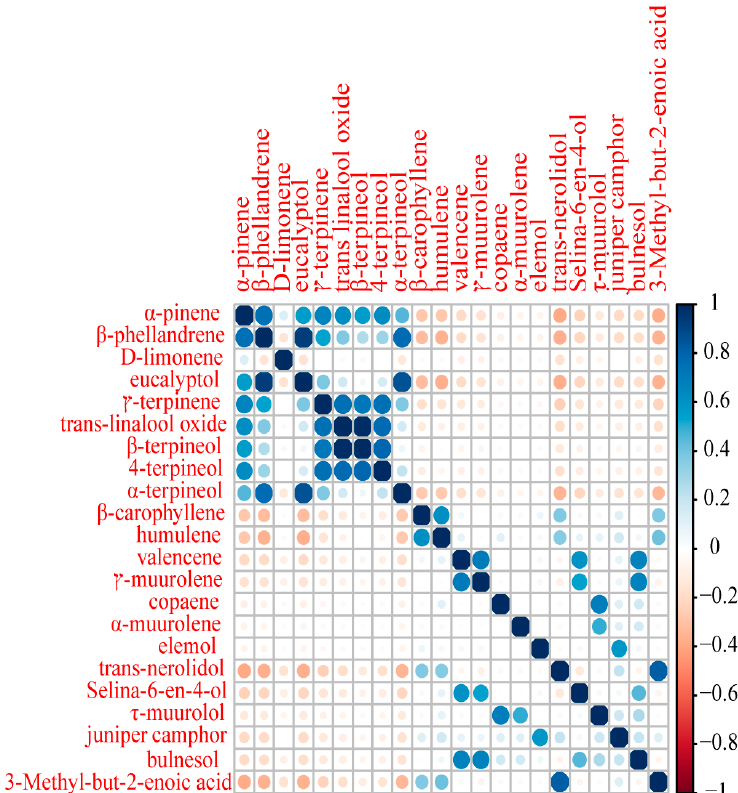
Figure 2. Correlation analysis of the 22 compounds identified in the essential oil of C. camphora .